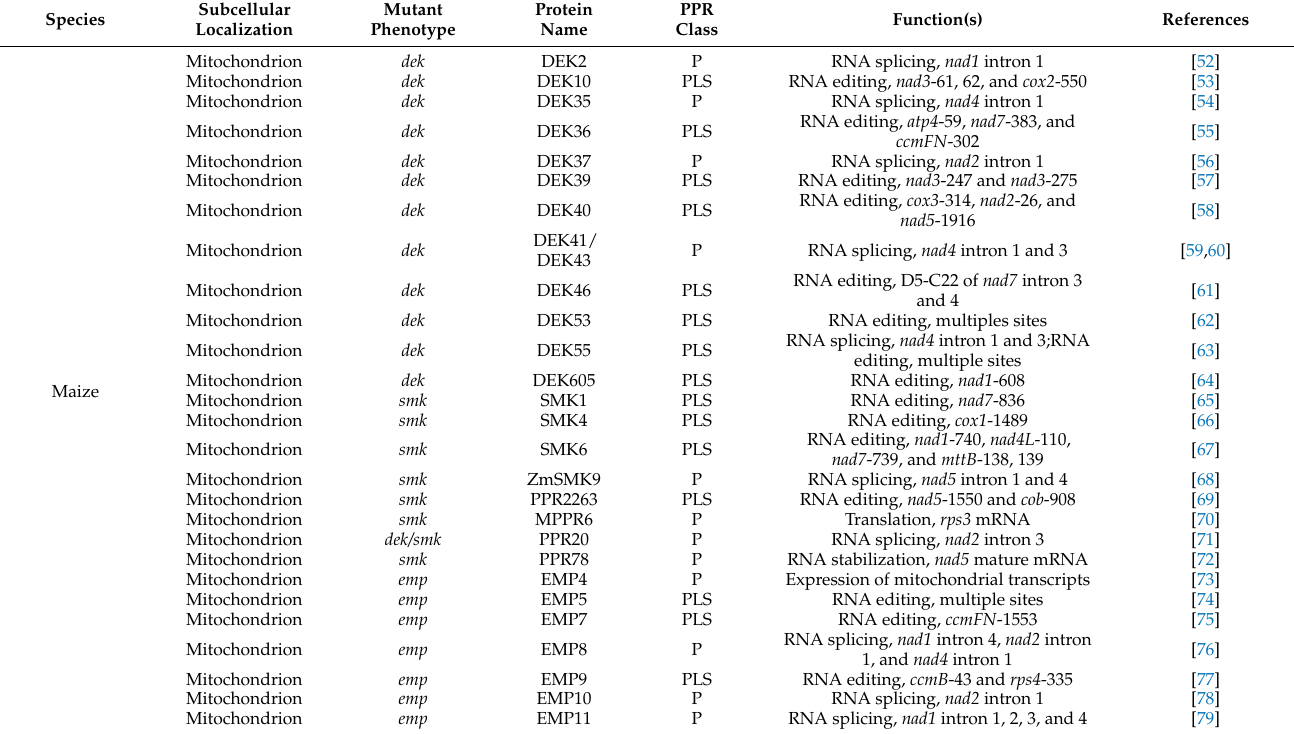
Table 1. Selected functionally characterized PPR proteins essential for seed development in maize and Arabidopsis.